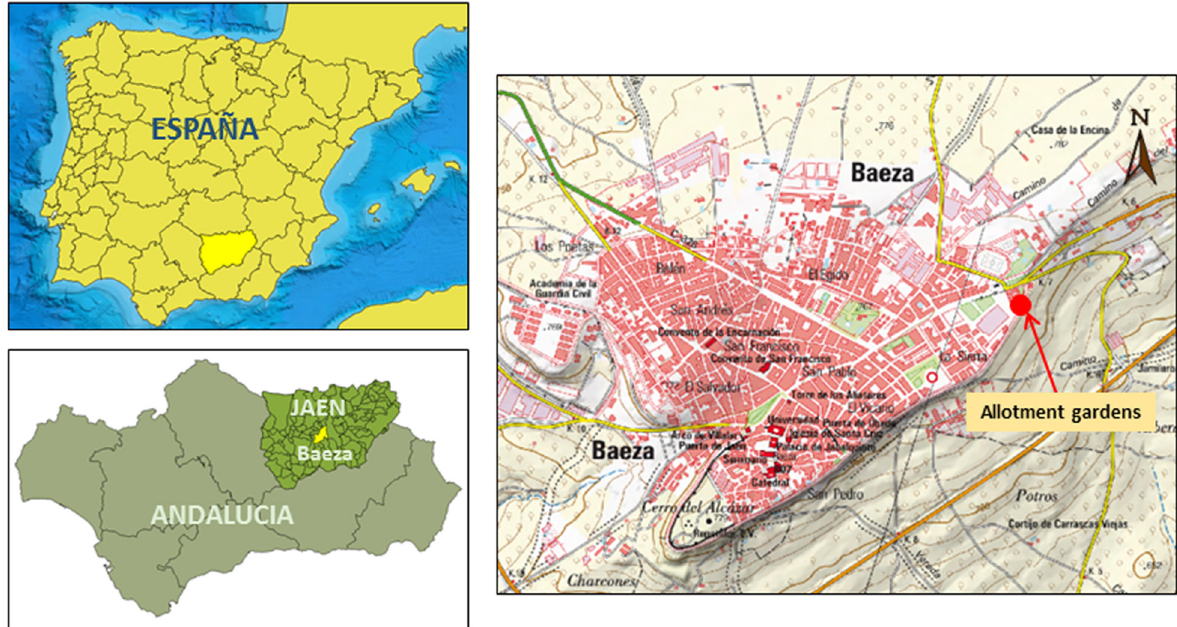
Fig. 4. The research area, its location from the perspective of the country, province and the city. Source: own